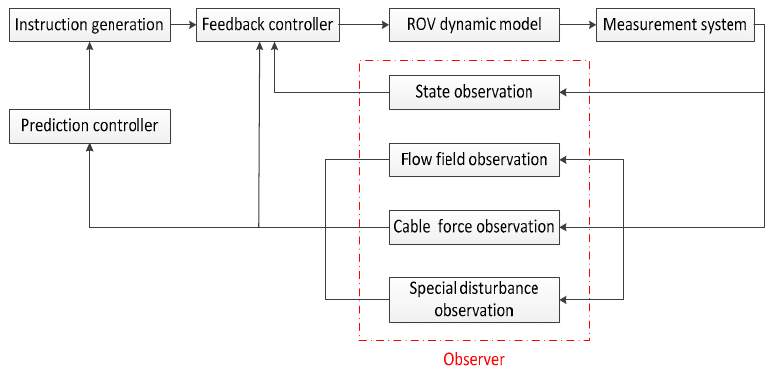
Figure 7. Control system structure of the ROV.